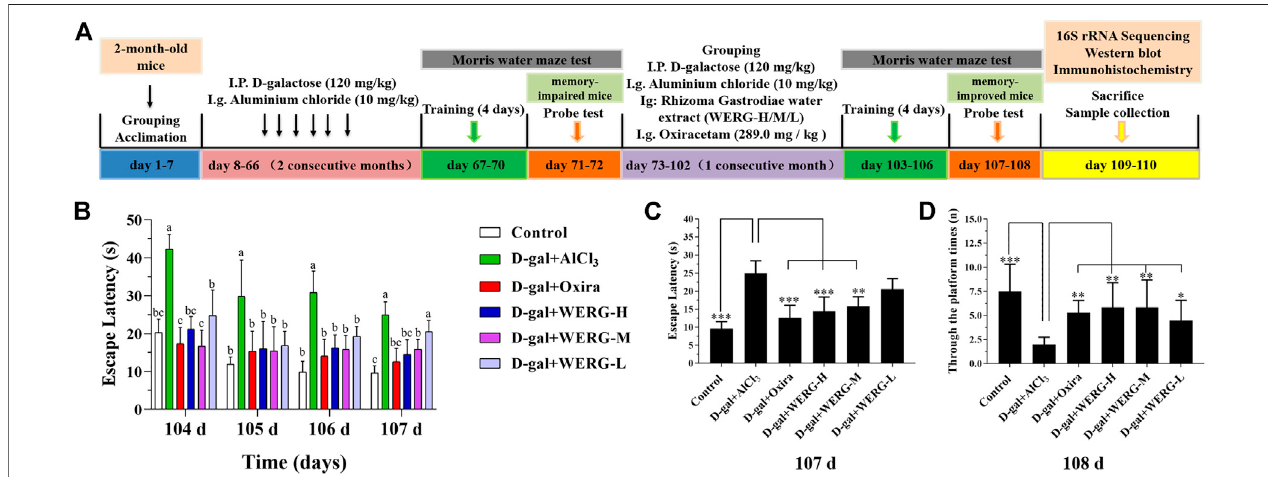
FIGURE 1 | WERG-H improved cognitive impairment in AD mouse model. Control, D-gal 120 + AlCl 3 10 mg/kg. bwt (D-gal + AlCl 3 ), D-gal 120 + AlCl 3 10 + Oxiracetam 298 mg/kg. bwt (D-gal + Oxira), D-gal 120 + AlCl 3 10 + Rhizoma Gastrodiae water extract 300 mg/kg. bwt (D-gal + WERG-H), D-gal 120 + AlCl 3 10 + Rhizoma Gastrodiae water extract 200 mg/kg. bwt (D-gal + WERG-M), D-gal 120 + AlCl 3 10 + Rhizoma Gastrodiae water extract 100 mg/kg. bwt (D-gal + WERG-L). Experimental protocols and prevention strategies (A) ; the escape latency during training (104 – 107 days) (B) ; escape latency (107 days) (C) ; after removal of the platform,throughtheplatformtimes(90 s) (D) .Datawereexpressedasmean±SD( n =8). “ * ” presentedsigni fi cantdifferenceat p < 0.05levels, “ ** ” presentedsigni fi cant difference at p < 0.01 level, “ *** ” presented signi fi cant difference at p < 0.001 level.